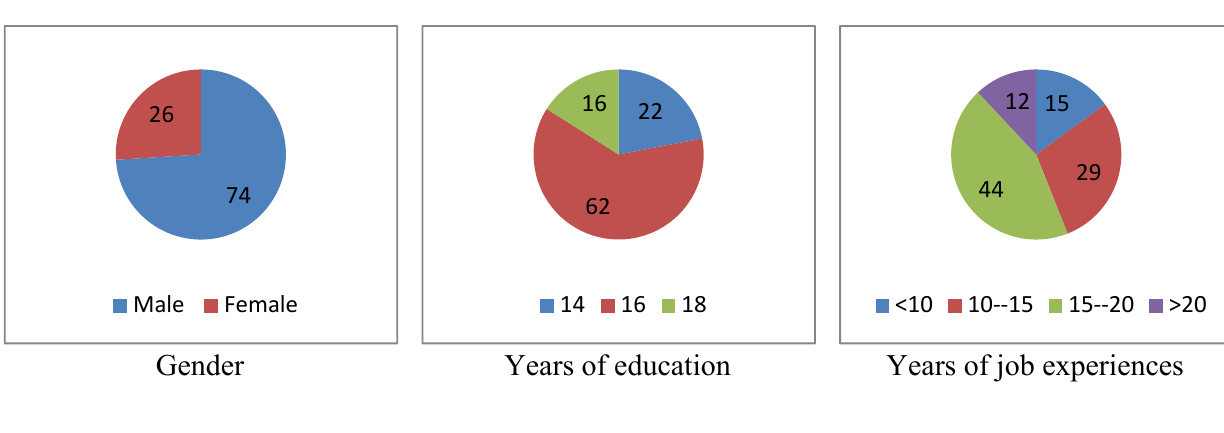
Fig. 1. Personal characteristics of the